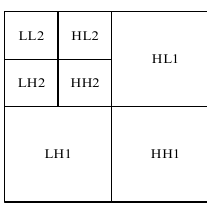
Figure 5. The DWT image two-level decomposition.